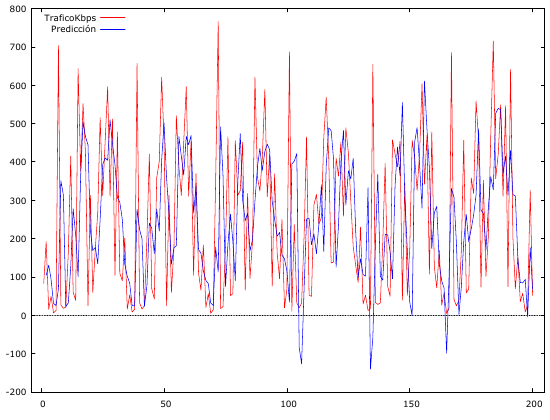
Figure 7. Prediction of the ARIMA model (1,1,1) .